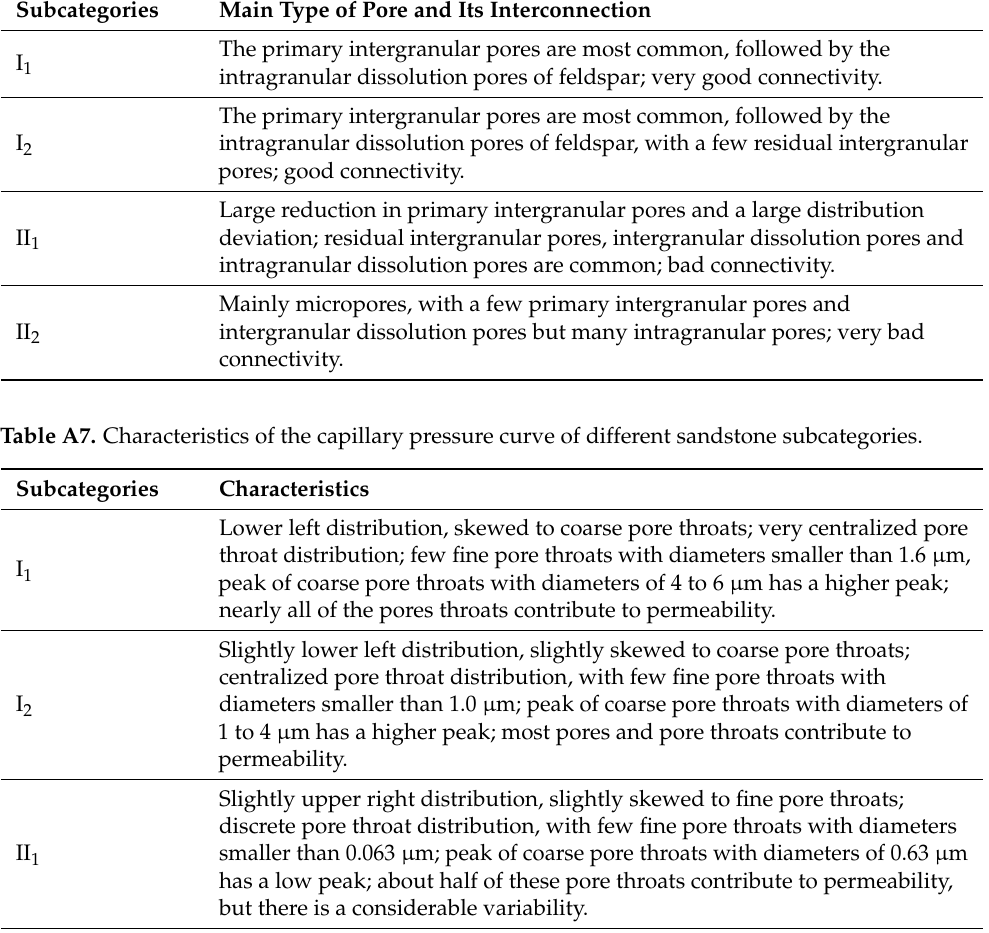
Table A6. Pore types and pore connectivity of different sandstone subcategories. Subcategories Main Type of Pore and Its Interconnection